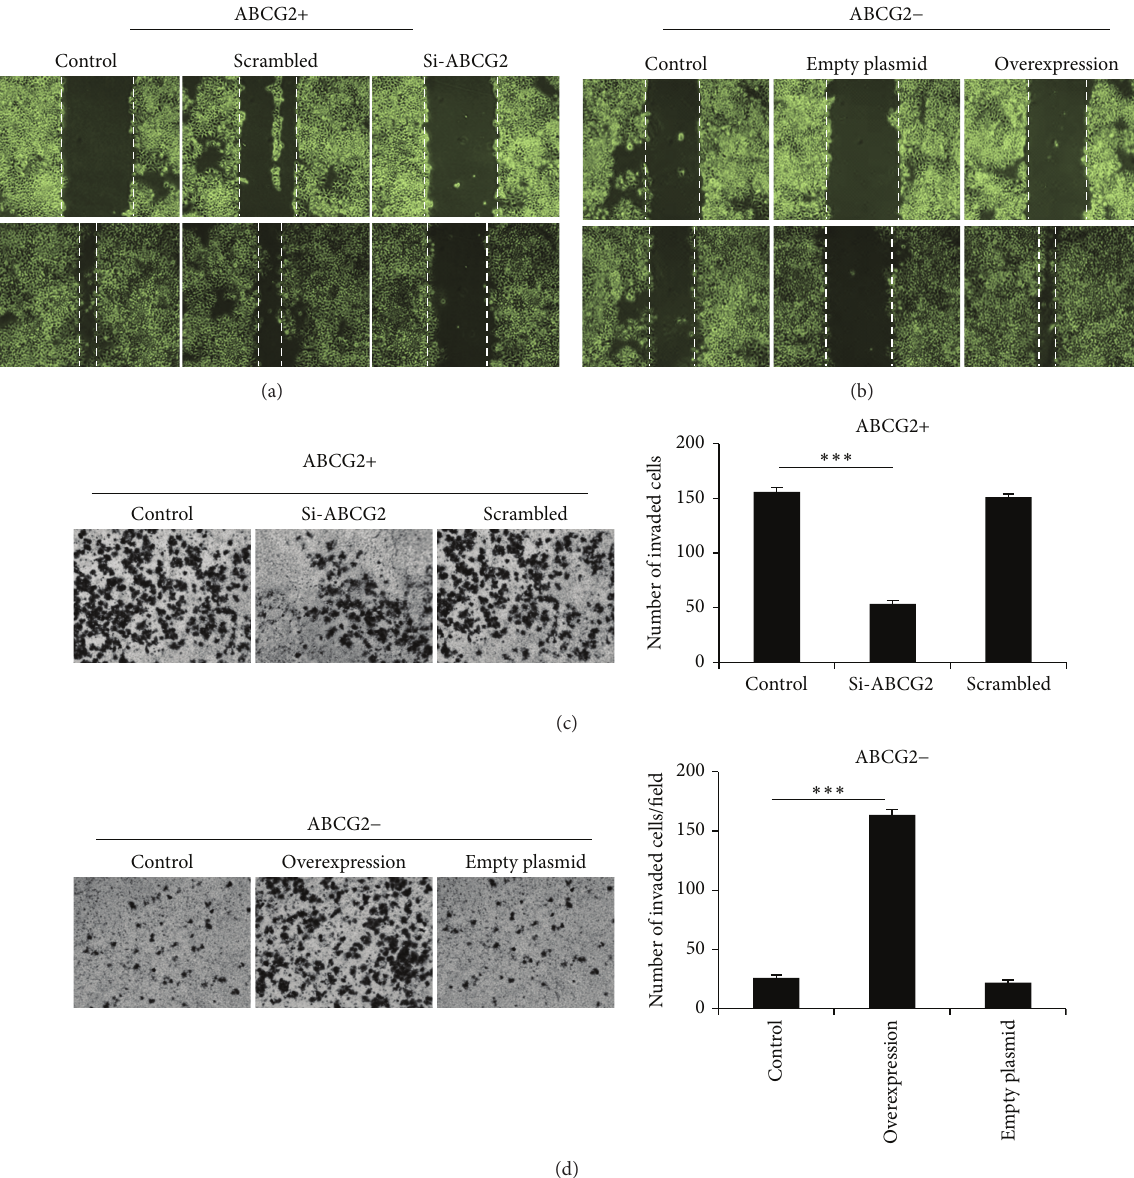
Figure 5: Downregulation or upregulation of ABCG2 had effect on migration and invasion potential in HCC cells. (a), (b) Wound healing assay evaluated the potential of migration of HCC cells. Untreated cells served as normal control. ABCG2+ cells were transfected with ABCG2 siRNA while ABCG2 − cells were transfected with ABCG2-expressing plasmid. Scrambled siRNA and empty plasmid were used as negative control. The pictures above represent the wound right after tip scratch. Pictures below showed wound-healing status after 48 h. (c), (d) Results of transwell invasion assay. After 48 h of invasion, cells invaded to the lower chamber were stained and photographed. Invaded cells were counted in three random visions and the average numbers were presented. ∗∗∗ 𝑃 < 0.001